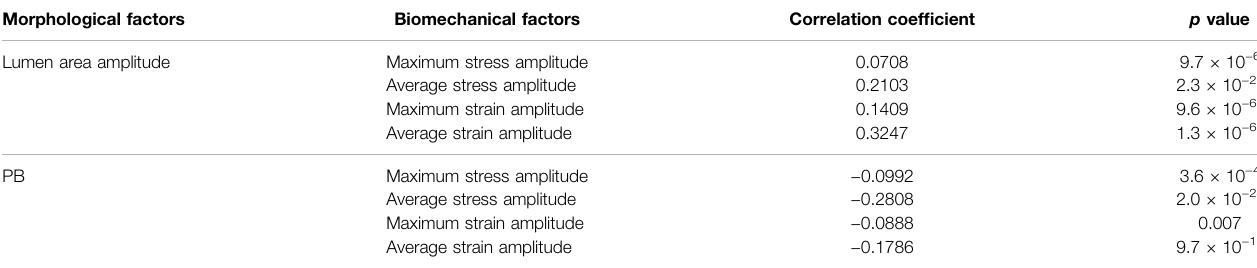
TABLE 1 | The correlation of morphological and biomechanical factors at baseline.